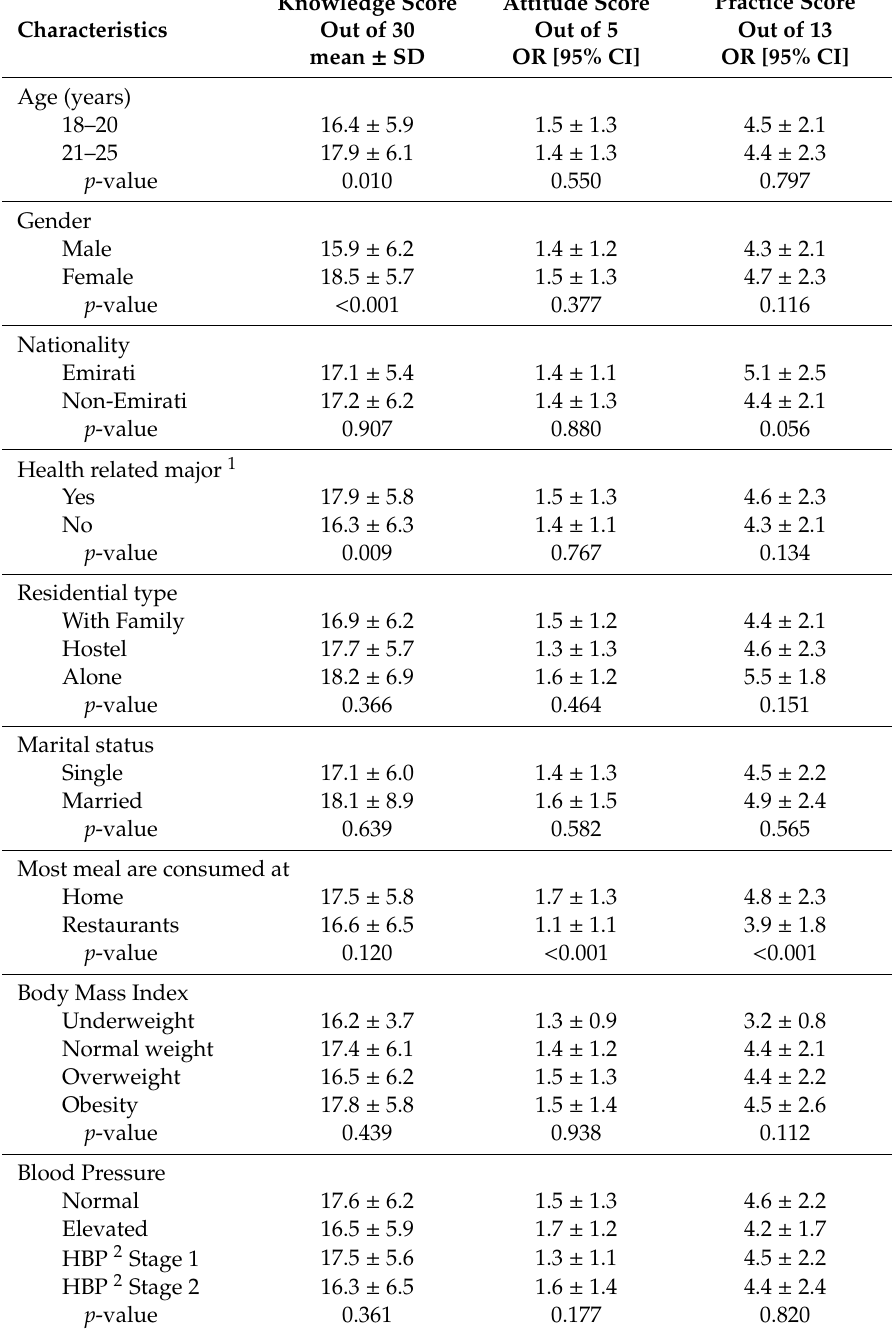
Table 5. Association of salt related knowledge, attitude, and practice scores among UOS students and their sociodemographic characteristics ( n =